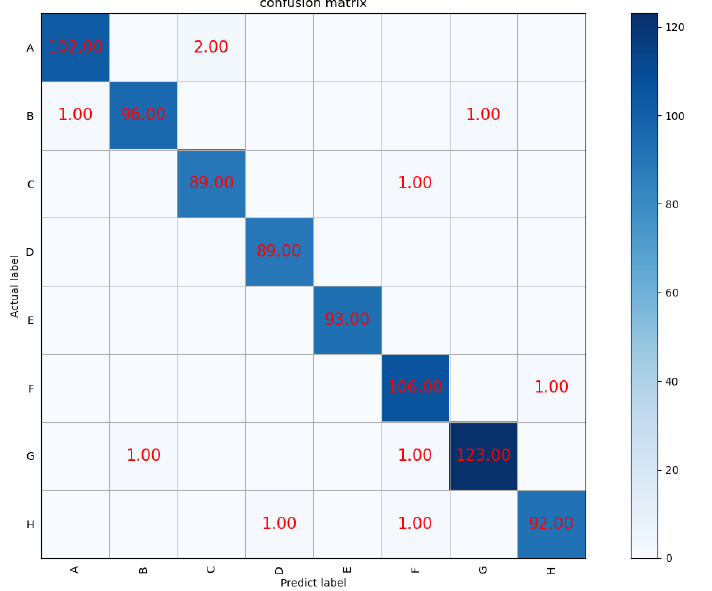
Figure 16. Confusion Matrix of the proposed